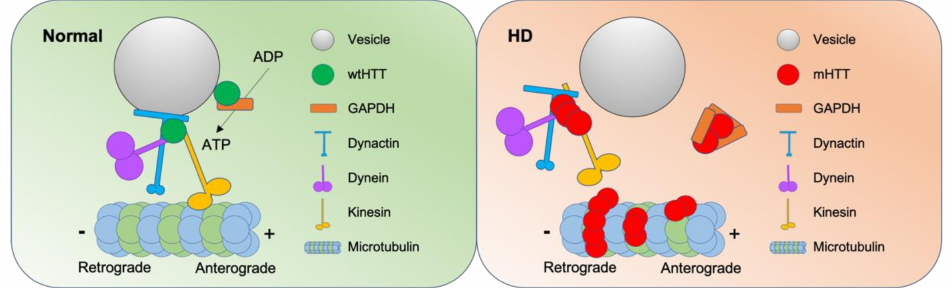
Figure 4. Role of HTT in normal vesicular transport and role of mHTT in disturbed vesicular transport in HD. In normal conditions, HTT participates in motor protein complex with dynactin, dynein, and kinesin. In addition, HTT recruits GAPDH to vesicles to supply energy, ATP to motor proteins. In HD, polyglutamine expansions of the mHTT sequester GAPDH and motor proteins. Microtubules are acetylated by mHTT to hinder binding of motor proteins on the microtubules. wtHTT recruits glyceraldehyde-3-phosphate dehydrogenase (GAPDH) to transport vesi- cles, where vesicular GAPDH produce adenosine 5 (cid:48) -triphosphate (ATP) to provide energy for the transport [126]. In HD pathogenesis, GAPDH is sequestered by mHTT [127,128], where the sequestration of GAPDH is rescued by high-affinity RNA aptamers that specifically rec- ognize mHTT [129]. In addition, HTT forms complexes of motor proteins with huntingtin- associated protein-1 and p150 Glued subunit of dynactin [130]. HTT-associated protein-1 binds to both kinesin-1 and vesicles to serve as an adaptor [131]. Huntingtin’s recruitment of kinesin-1 is governed by the phosphorylation of wtHTT at serine421 (Ser421), which stimulates anterograde transport [132]. Interestingly, phosphorylation of HTT (Ser421) protects against the mHTT toxicity, where the endogenous level of phosphorylated HTT (Ser421) is least in the striatum